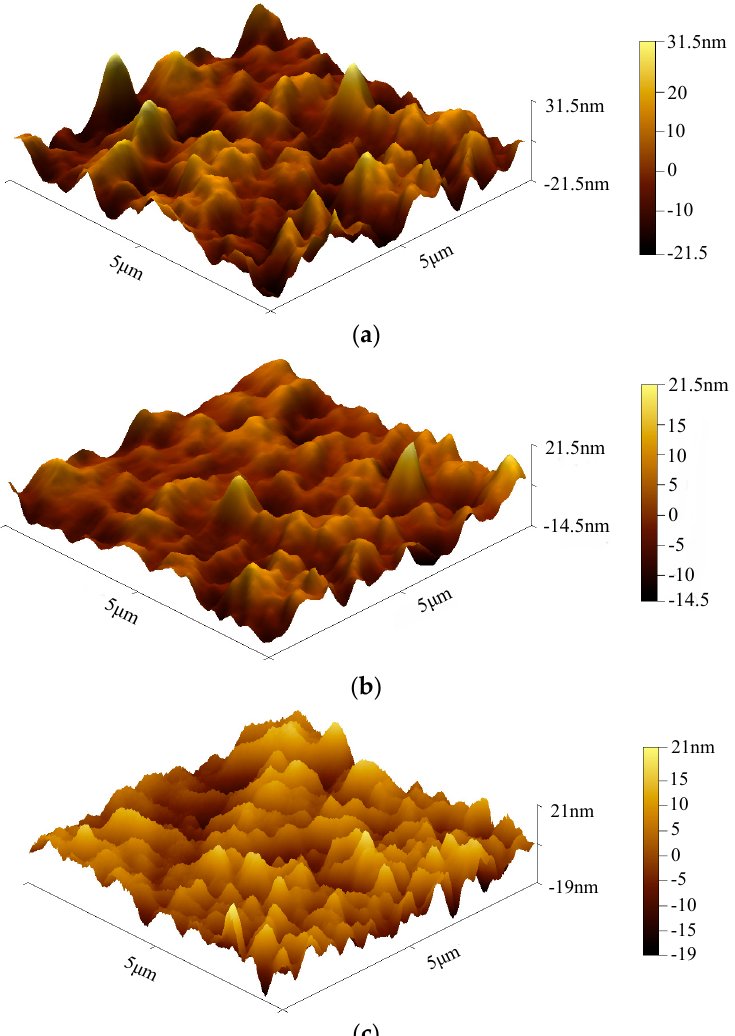
Figure 14. AFM image of surface topography of NiCr film. ( a ) AFM image of NiCr thin-film without surface temperature. ( b ) AFM image of NiCr thin-film with surface temperature. ( c ) AFM image of NiCr film after ion beam etching.